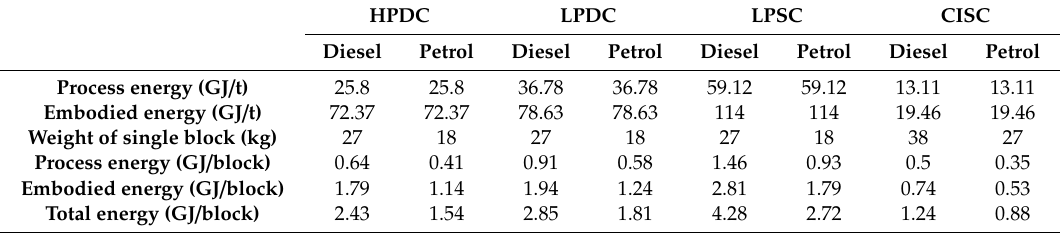
Table 11. Total energy per engine block. HPDC—high-pressure die casting; LPDC—low-pressure die casting; LPSC—low-pressure sand casting; CISC—cast-iron sand casting.